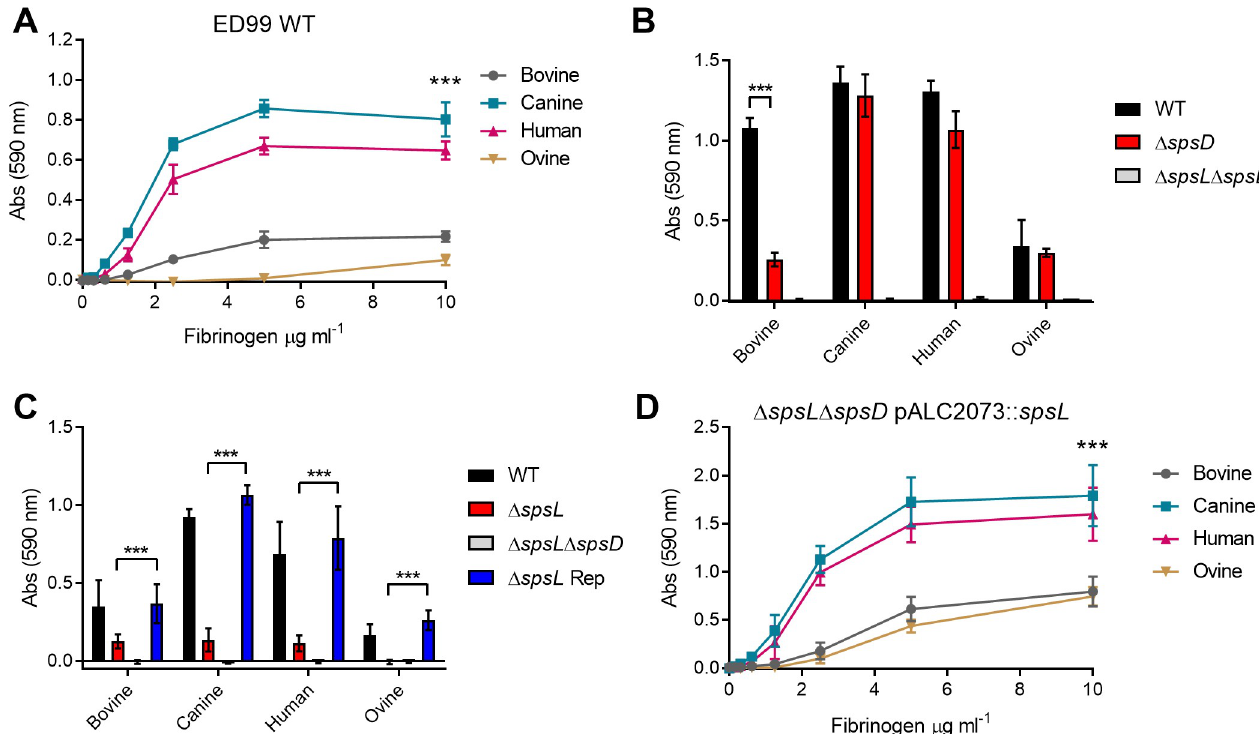
Fig 1. SpsL exhibits host-specific binding to fibrinogen. Bacterial adherence assays using crystal violet staining were used to quantify fibrinogen-binding from 4 host species–bovine, canine, human, and ovine. (A) Adherence of S . pseudintermedius ED99 wild type (WT) when cultured to mid-exponential growth phase. Data points represent the mean ± SD (n = 3). Differences in binding to fibrinogen was analyzed at 10 μ g ml -1 fibrinogen (p � 0.001, two-way ANOVA) (B) Adherence of WT, ED99 Δ spsD , and ED99 Δ spsL Δ spsD to 20 μ g ml -1 fibrinogen when cultured to early-exponential growth phase. (C) Adherence of WT, ED99 Δ spsL , ED99 Δ spsL Δ spsD , and ED99 Δ spsL Rep to 20 μ g ml -1 fibrinogen when cultured to mid-exponential growth phase. Error bars represent SD (n = 9). Differences in fibrinogen-binding was analyzed (p � 0.001, t-test) (D) Adherence of ED99 Δ spsL Δ spsD expressing SpsL. Data points represent the mean ± SD (n = 9). Differences in binding to fibrinogen from multiple hosts was analyzed at 10 μ g ml -1 (p � 0.001, two-way